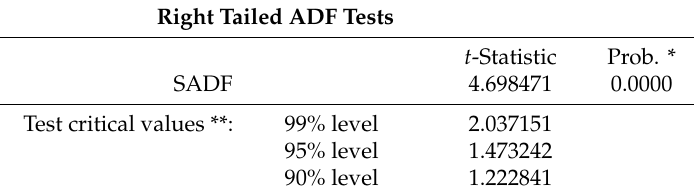
Table 1. Supremum Augmented Dickey–Fuller (SADF) results for Brent Crude oil price.